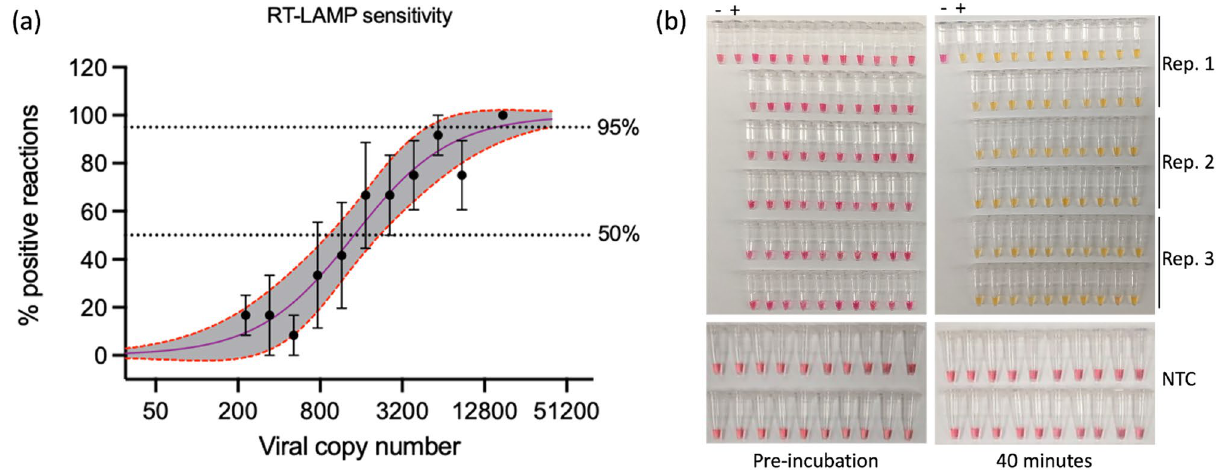
Figure 2. Limit of detection and validation of analytical sensitivity and specificity on virus-spiked anterior nasal swab collection media. ( a ) Serial dilutions of heat-inactivated SARS-CoV-2 strain WA-1/2020 by percent positive samples. Three independent replicates of four-reactions per dilution were performed using samples from 227 copies per reaction to 17,473 copies per reaction. X-axis is log-scale showing copies per reaction, Y-axis shows % positive reactions. Each data point shows the average and standard error of the mean (SEM) for each set of replicates per dilution. A Sigmoidal dose–response curve was fit using the Find ECAnything least squares fit in Graphpad Prism 7.0 with lower and upper limits of 0 and 100 respectively. Red-dotted lines and grey area indicates 95% confidence interval around the dose–response curve. Straight dotted lines show 50 and 95% analytic sensitivity intercepts as predicted by the fitted curve. 95% limit of detection was 15,514 viral copies, 50% limit of detection was 1421 viral copies per reaction. ( b ) 20 replicates of non-template control (NTC, anterior nasal swab media only; bottom panels) versus 15,518 viral copies of heat-inactivated SARS-CoV-2 (top panels) in uninfected pooled anterior nasal swab media, demonstrating ≥ 99% analytical specificity and ≥ 95% analytical sensitivity at 15,518 copies/reaction. Nuclease-free water non-template control (−) and BEI RNA positive control (+), indicated. Pre-incubation and incubation times and colorimetric changes as